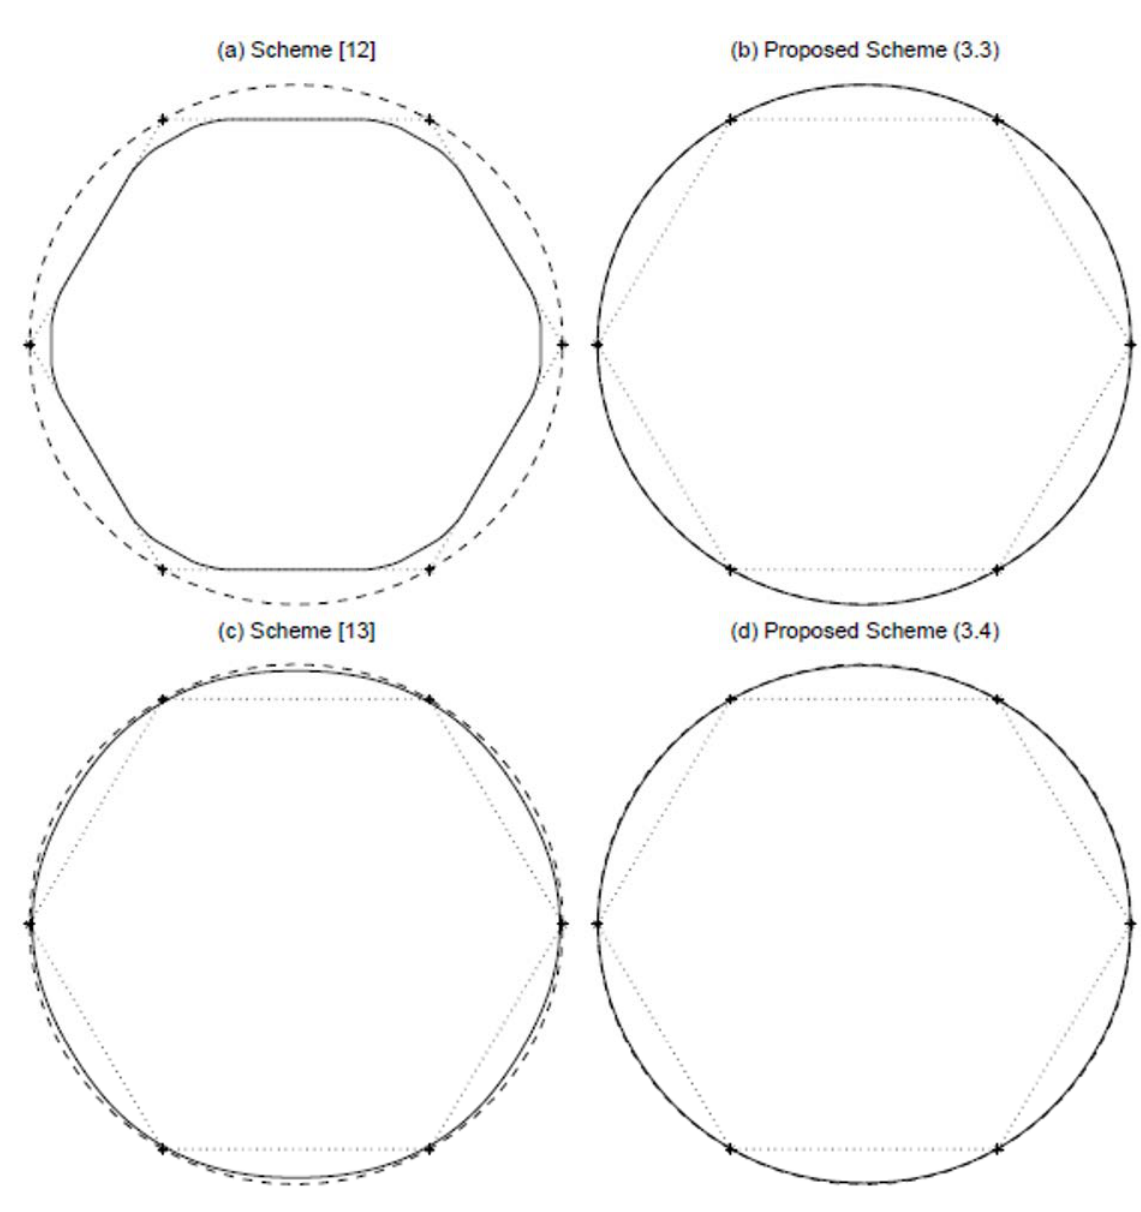
Figure 1. The reproduction of unit circle after three subdivision steps, the continuous lines represent the limit curves: scheme [12] in (a), proposed scheme(8)in(b), scheme[13]in(c)andproposedscheme(11)in(d). Thebrokencurvesrepresentunitcircleanddottedlinesrepresent regular hexagon (initial control